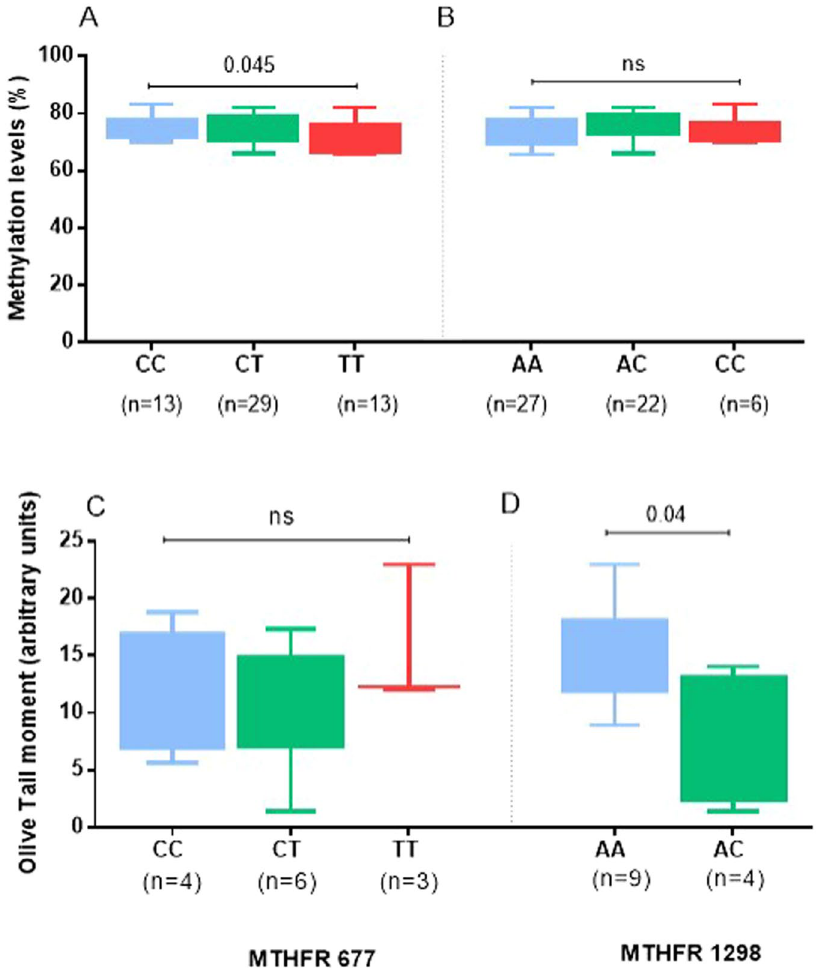
Figure 1. Long interspersed nuclear element 1 (LINE-1) promoter methylation according to MTHFR genotypes and intrinsic DNA damage levels in pSS patients according to MTHFR genotypes. Panel A: Significantly lower DNA methylation levels among individuals bearing the MTHFR c. 677C > T TT genotype, compared to the CC carriers were observed (TT vs CC: 71.57 ± 5.43 vs 75.56 ± 4.13, p = 0.045). Panel B: No statistically significant differences in DNA methylation levels of LINE-1 promoter were observed among c. 1298A > C CC, AC and AA genotype groups (CC vs AC vs AA: 73.70 ± 5.00 vs 75.42 ± 4.89 vs 73.41 ± 4.98, all comparisons non significant). Panel C: No statistically significant differences in DNA double-strand break levels (expressed as Olive Tail Moments, arbitrary units) between MTHFR c. 677C > T genotypes (CC vs CT vs TT: 11.67 ± 5.40 vs 11.23 ± 5.53 vs 15.74 ± 6.30). Panel D: Decreased levels of comet assay units among pSS patients carrying the MTHFR c. 1298A > C AC genotype compared to those bearing the c. 1298A > C AA genotype (AA vs AC: 14.41 ± 4.38 vs 7.89 ± 5.54, p = 0.04). MTHFR: methylene tetrahydrofolate reductase, pSS: primary Sjogren’s